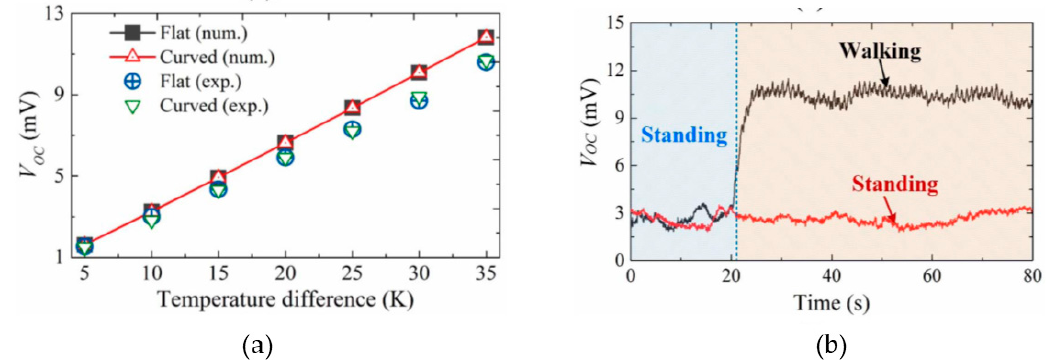
Figure 22. ( a ) Comparison of TEG voltage on flat and curved surface; ( b ) TEG voltage generated during walking and standing [113].